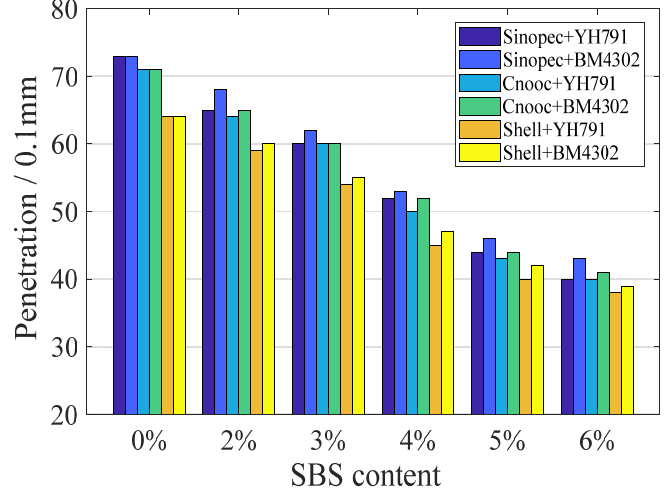
Figure 2. Penetration at 25 °C of all samples.